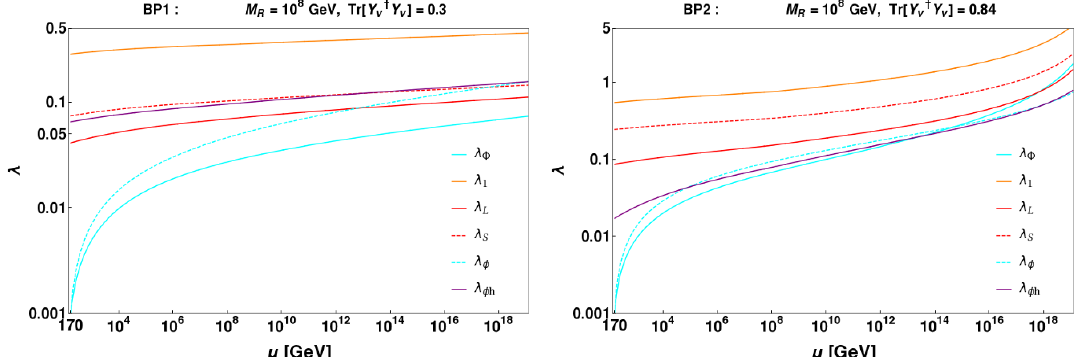
Figure 21 . RG running of all the quartic couplings in metastability criteria for BP1 (left) and BP2 (right) to ensure the boundedness of the scalar potential in various (cid:12)eld directions with energy scale (cid:22) for Tr[ Y y Y (cid:23) ] = 0 : 3 (left) and 0.84 (right). The choices of Tr[ Y y (cid:23) (0.3) and in orange (0.84) in left and right panels of (cid:12)gure 20 to yield metastability.